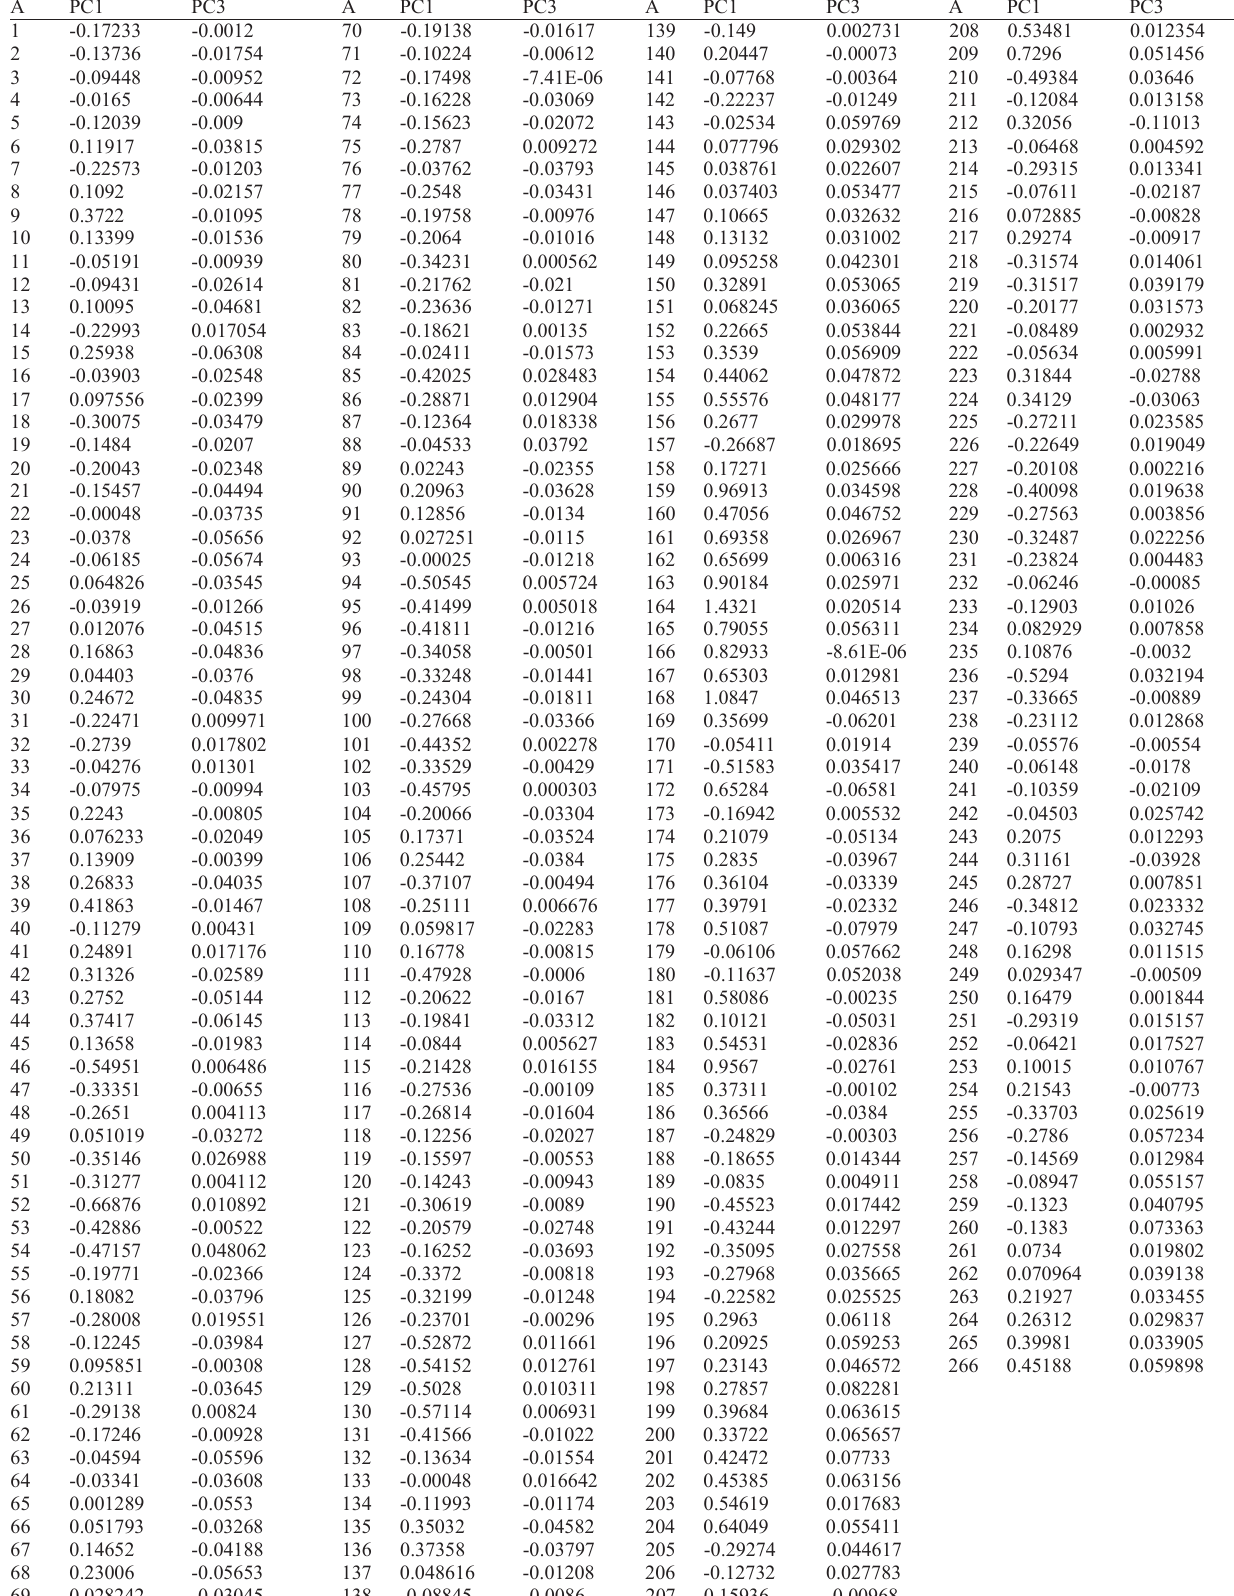
Table 3. Individual scores of the first and third Principal Component axis for Astyanax laticeps . A = specimens; 1-68, from laguna dos Patos; 69-142, Tramandaí; 143-168, Mampituba; 169-184, Tubarão; 185-209, Itajaí-Açu; 210-224, Itapocu; 225-266, Cubatão